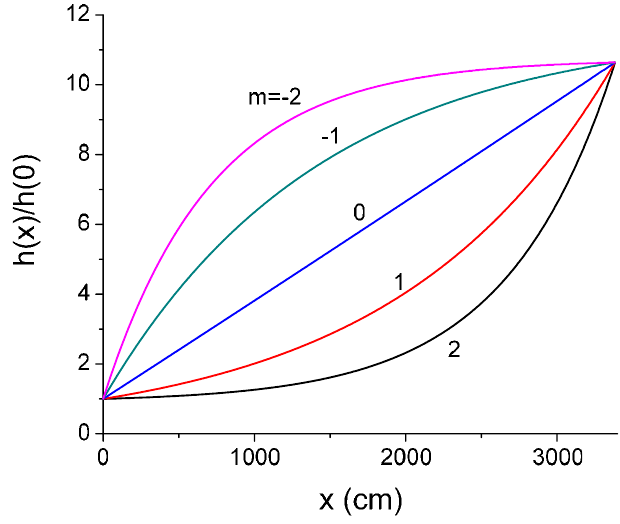
FIG. 5. (Color) Equivalent planar-transmission-line gap profiles of the normalized gap h (cid:3) x (cid:4) =h (cid:3) 0 (cid:4) as a function of x .